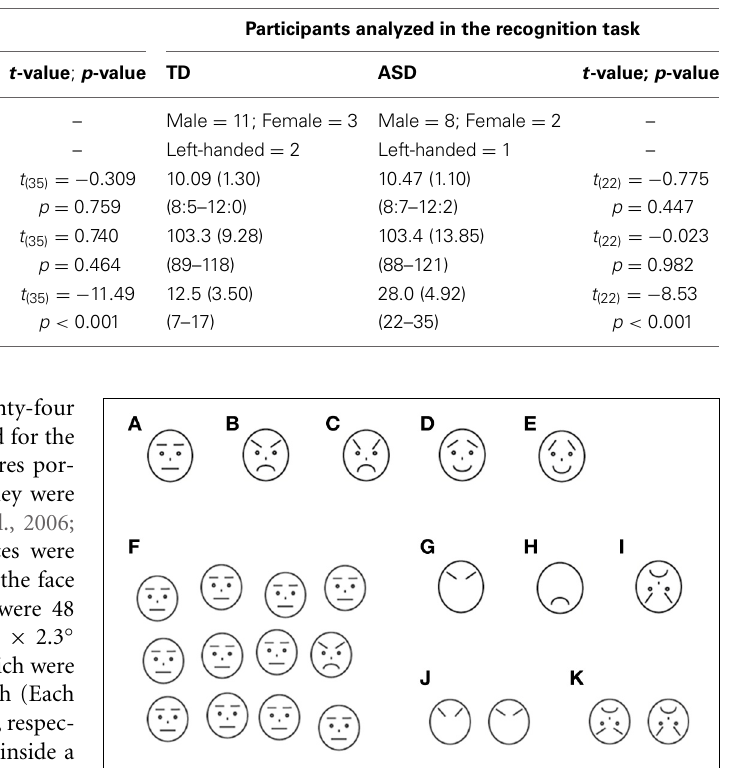
FIGURE 1 | Stimuli used in this study. (A) Neutral face (B) Angry face with Emotion-degree1 (C) Angry face with Emotion-degree2 (D) Happy face with Emotion-degree1 (E) Happy face with Emotion-degree2 (F) Examples of matrix in the search: one angry face with Emotion-degree1 and 11 distractor neutral faces (G–I) Examples of the stimuli used in the recognition task; (G) Eyebrows of angry face with Emotion-degree1 (H) Mouth of angry face with Emotion-degree2 (I) Inverted angry face with Emotion-degree2 (J), (K) Examples of the choices in the recognition